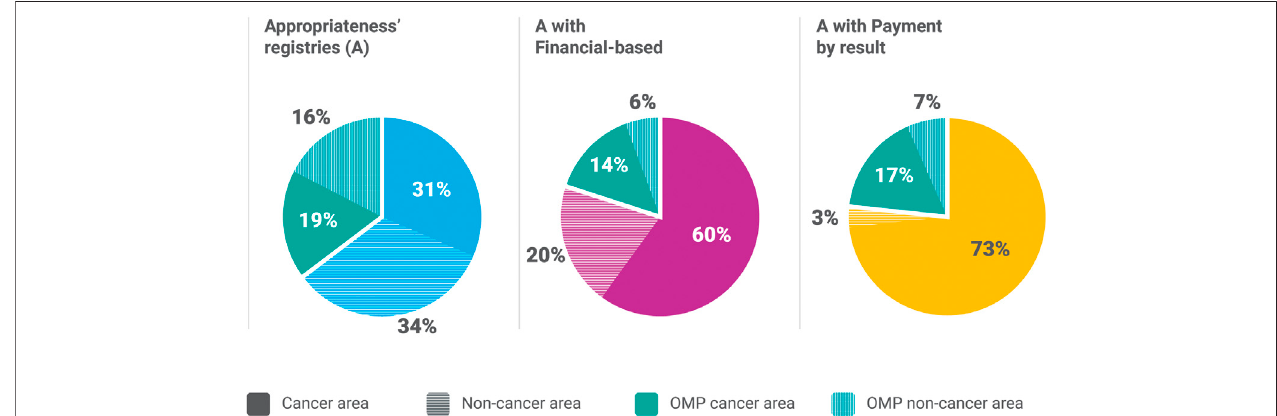
FIGURE 3 | AIFA MEAs distribution in cancer (solid color) and non-cancer indications (color with pattern).